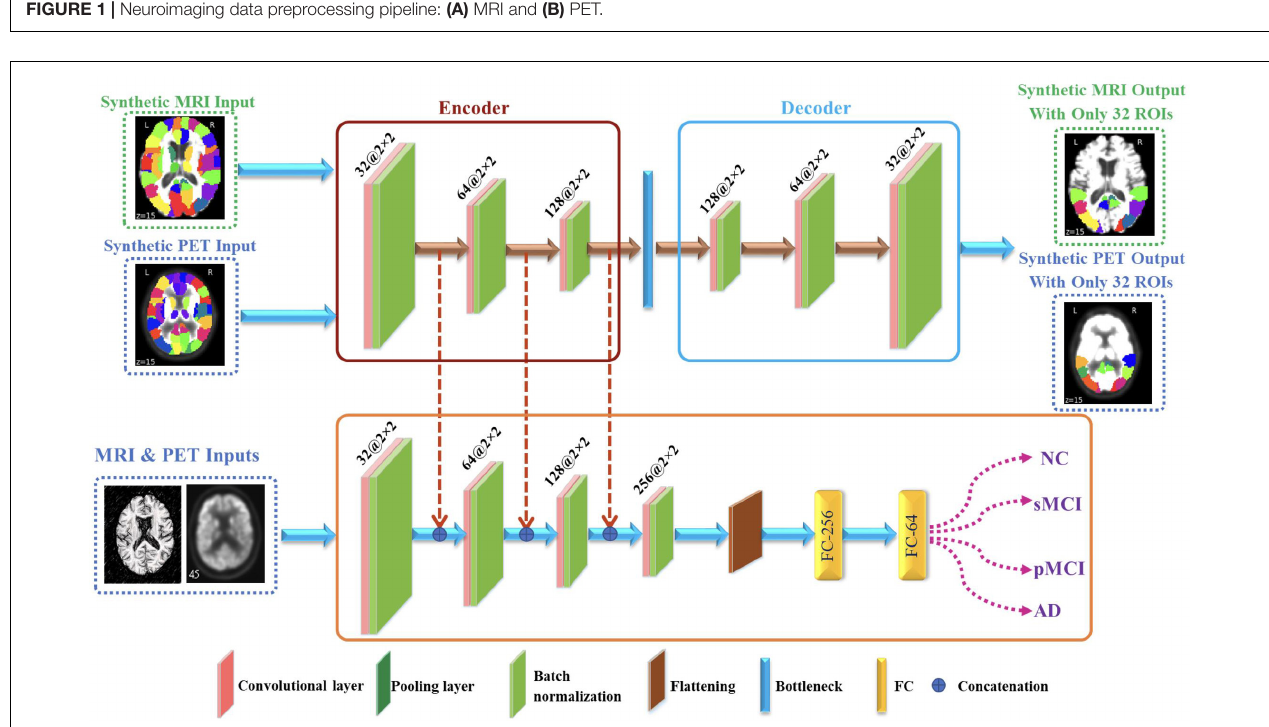
FIGURE 2 | Proposed framework that utilizes convolutional auto-encoder and CNN for brain disease classification.